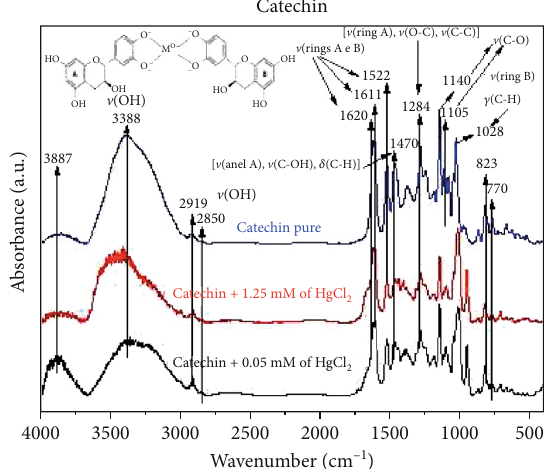
Figure 4: Membrane damage in Lactuca sativa caused by 0.05mM HgCl in the absence and presence of quercetin. 2 ) and in 2